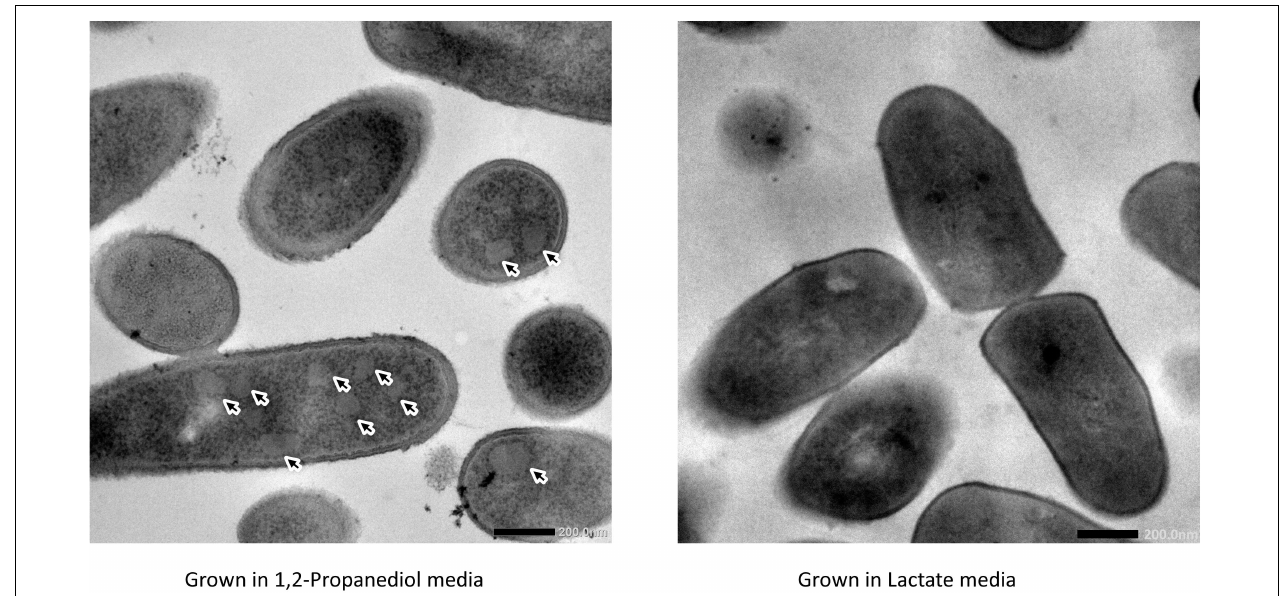
FIGURE 3 | Visualization of bacterial microcompartments in propanediol media (left) and absence in lactate media (right) .